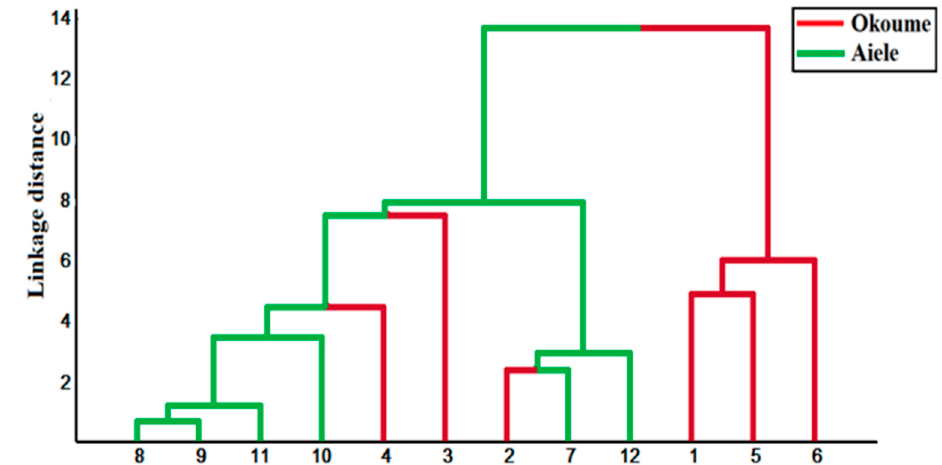
Figure 10. Hierarchical cluster analysis (HCA) dendrogram of the two essential oil samples measured using the conductance change (Delta-G) of sensors as a response feature.